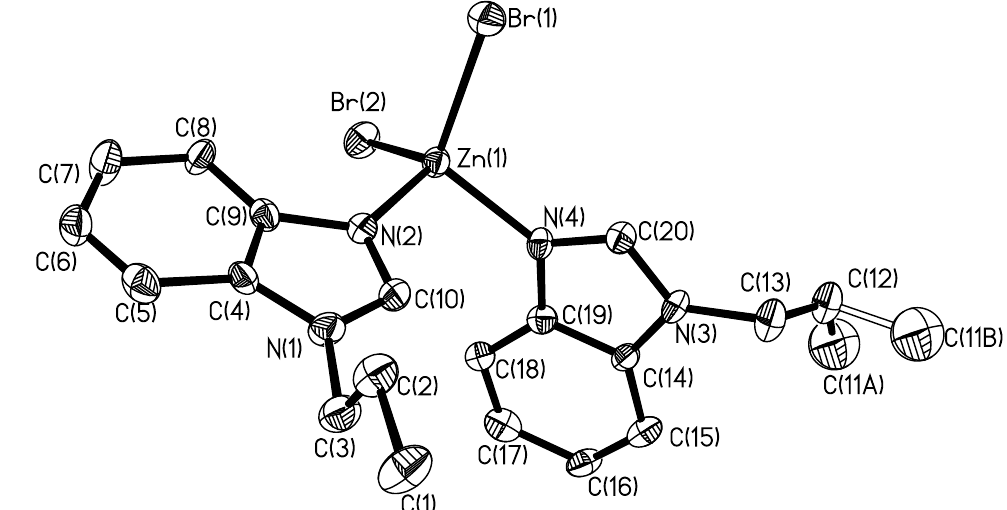
Figure 1. The molecular structure of [Zn(C